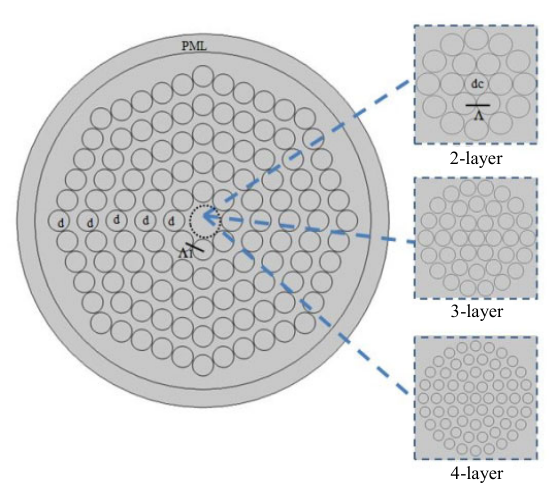
Fig. 1 Transverse cross-sectional view of the proposed P-